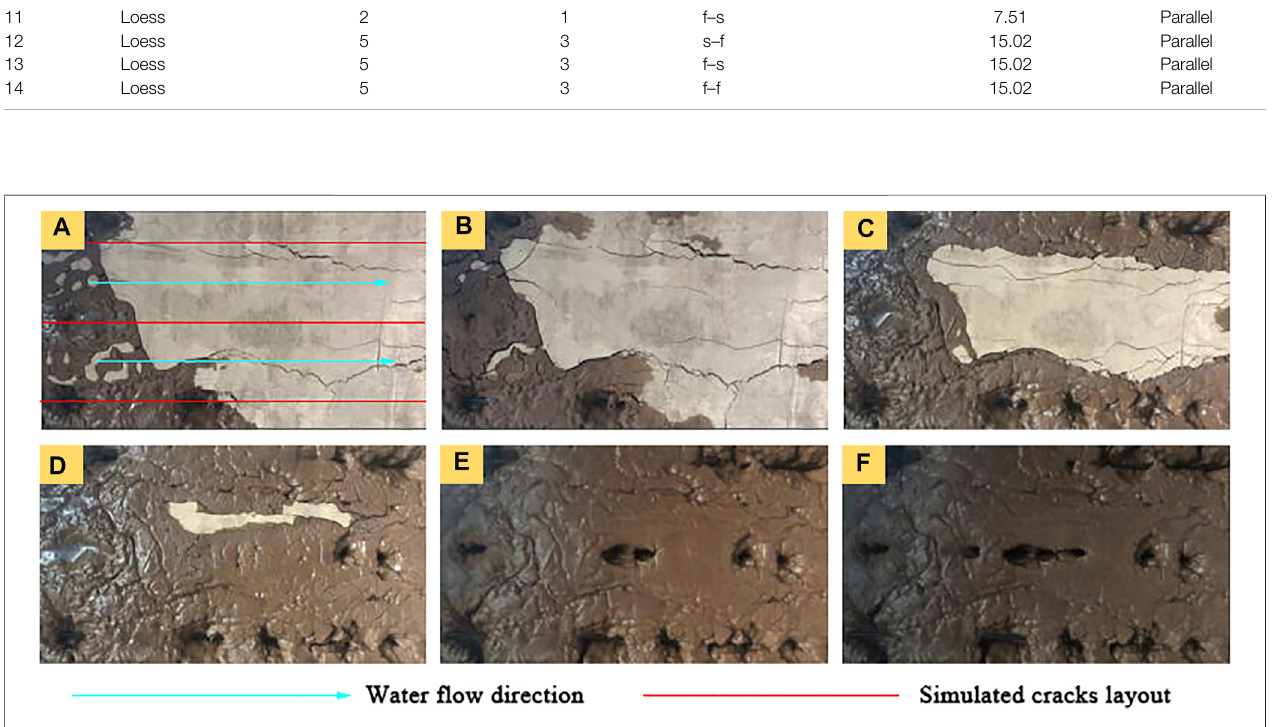
FIGURE 9 | Test results of 2-cm-thick soil layer and 1-cm con fi ned water level. (A) After the fi rst water reserve – discharge cycle, (B) after three water reserve – discharge cycles; (C) after fi ve water reserve – discharge cycles; (D) after seven water reserve – discharge cycles; (E) after ten water reserve – discharge cycles; and (F) after thirteen water reserve – discharge